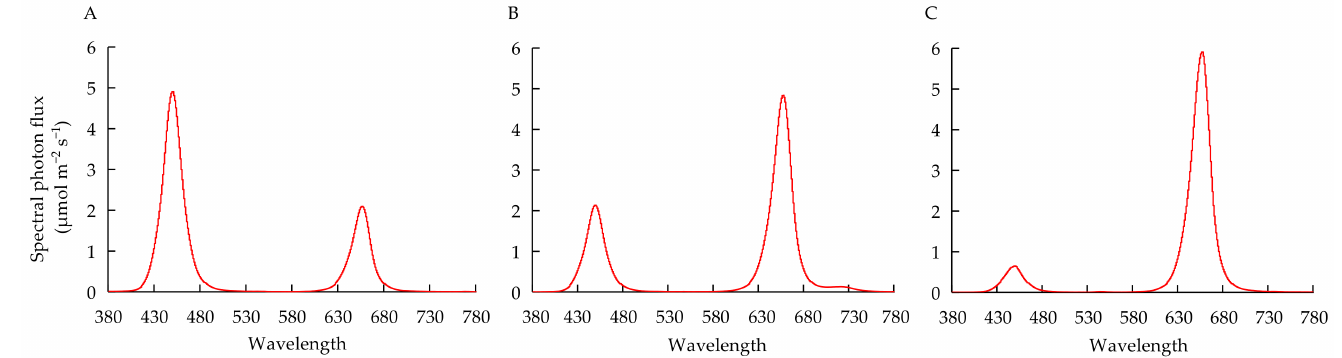
Figure 1. Spectral distribution of the LED lamps of RB3:7 ( A ) RB7:3 ( B ) and RB9:1 ( C ) used in the experiment.